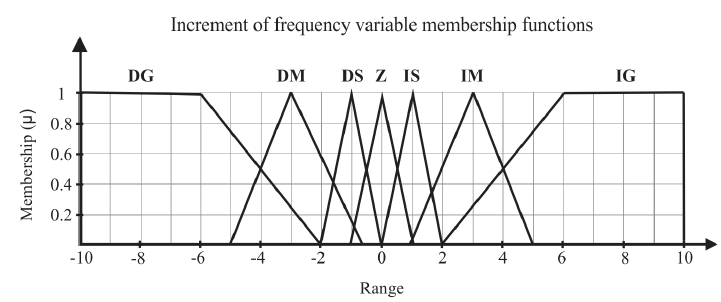
Figure 6. Output variable membership function.